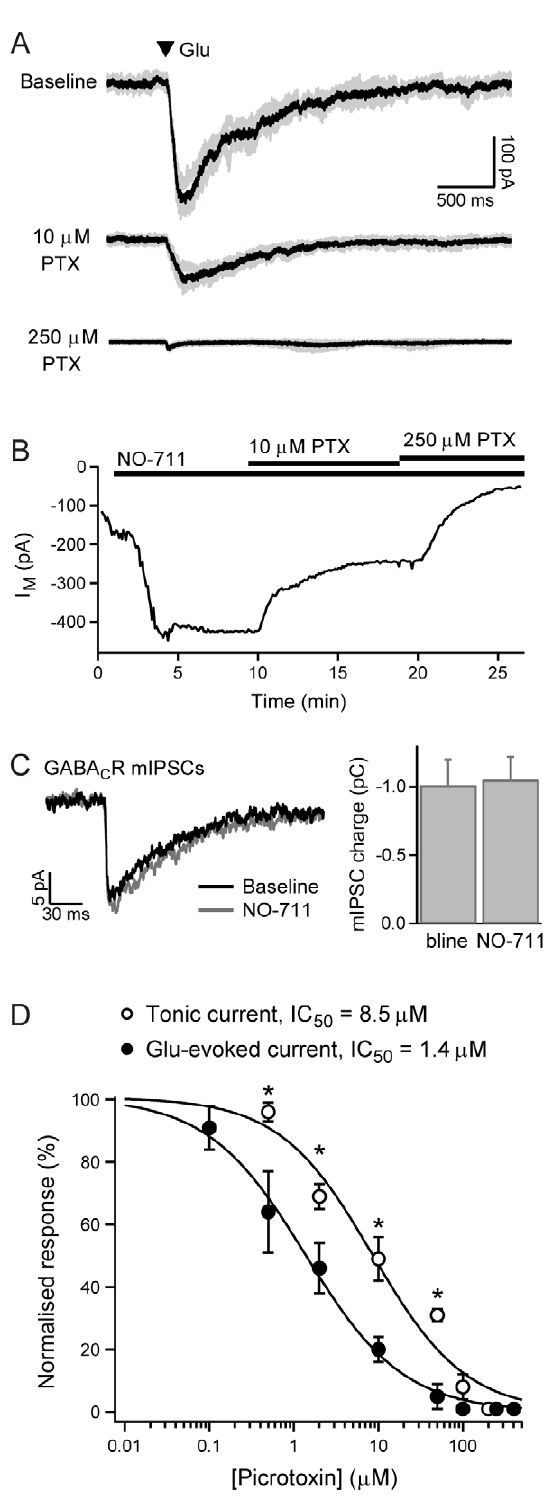
Figure 4. Picrotoxin-sensitivity of GABA C R currents. A, Example GABA C R responses evoked by local application of L-glutamate (glu; 100 m M, 10 ms) to activate reciprocal amacrine cell synapses, and their inhibition by picrotoxin. Three individual responses (grey) and the mean response (black) are shown for each condition. B, An example experiment showing inhibition of the tonic GABA C R current by the same concentrations of picrotoxin, following potentiation of the current by NO-711 (3 m M). C, Example average GABA C R-mediated